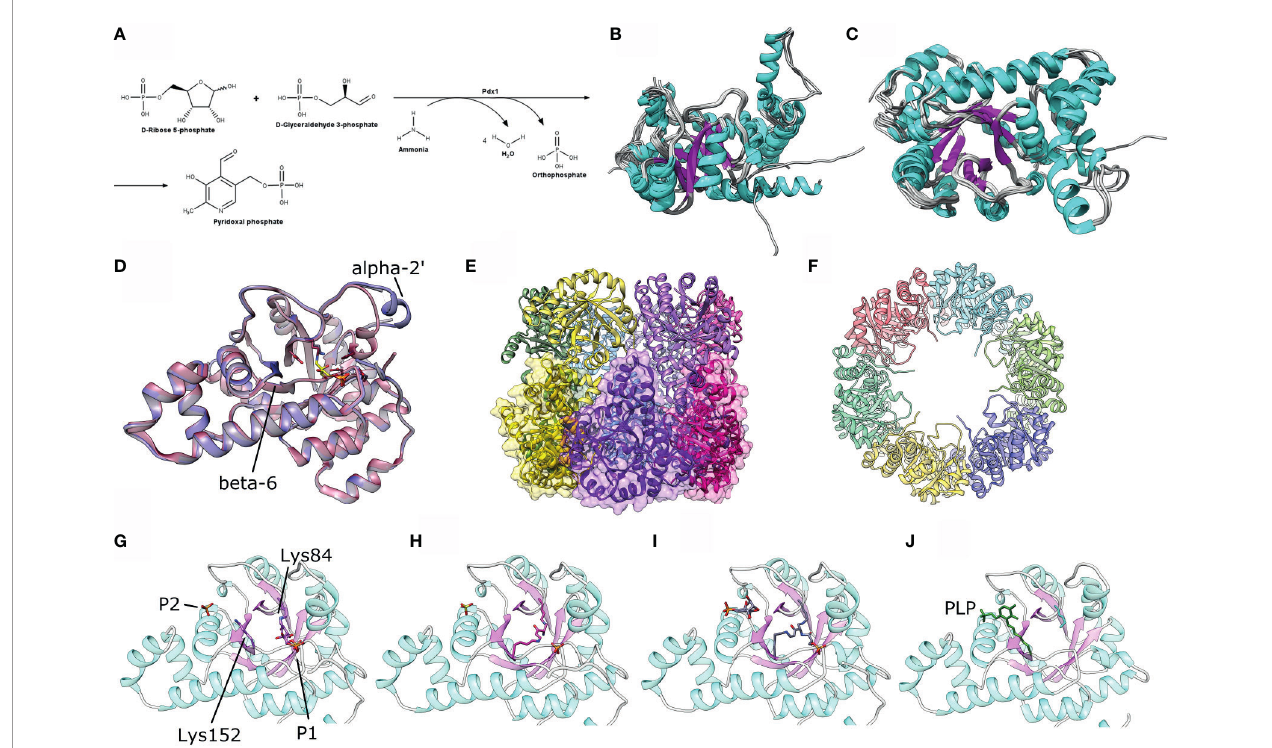
FIGURE 1 | (A) Scheme for the enzymatic reaction catalyzed by Pdx1. (B, C) Two orthogonal views of a structural alignment of one representative structure of each organism, as available in the PDB for P. berghei (PDB ID: 4ADU), A . thaliana (5LNR), T. maritima (2ISS), T. thermophilus (2ZBT), G . kaustophilus (4WY0), G . stearothermophilus (1ZNN), B. subtilis (2NV1), S. cerevisae (3FEM), M. tuberculosis (4JDY), M. jannaschii (2YZR) and P. horikoshii (4FIQ). (D) Comparison between the crystal structure of P. berghei Pdx1 in the absence (red cartoon, PDB ID 4ADU) and presence (blue cartoon, PDB ID 4ADS) of Pdx2. (E, F) Two orthogonal views of the assembled Pdx1 dodecamer. The bottom hexamer is shown in (E) as cartoons and transparent surfaces. (G, H) Different steps in A . thaliana Pdx1 catalysis: (G) Pdx1 covalently attached to R5P; (H) Pdx1 intermediate I 320 ; (I) Pdx1 intermediate I 320 -G3P; (J) Pdx1 covalently bound to the product PLP. The catalytic lysines are shown in sticks presentation and indicated in the fi gure. The fi gure was prepared with the program UCSF Chimera (Pettersen et al.,